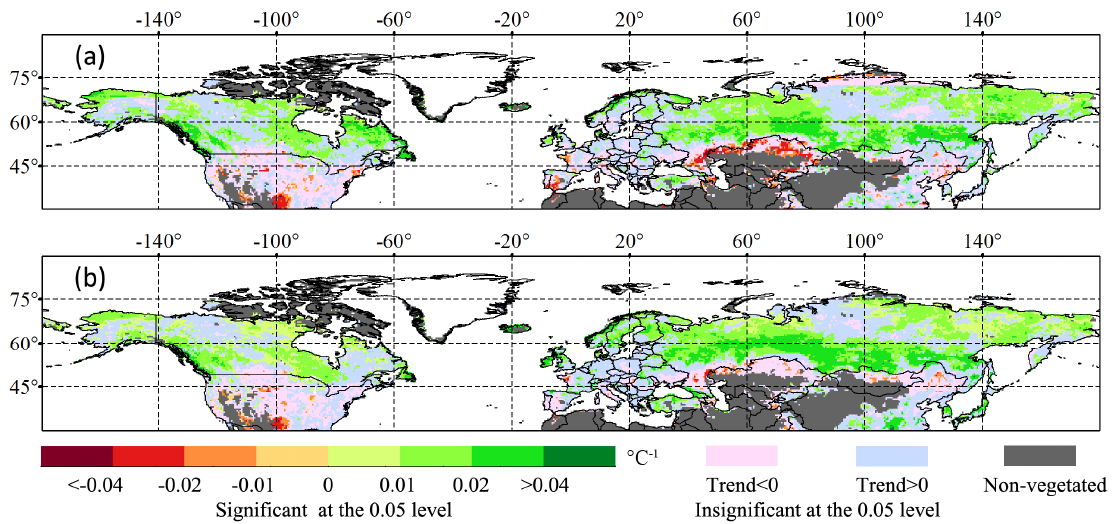
Figure 8. Response of growing-season NDVI to temperature change detected from